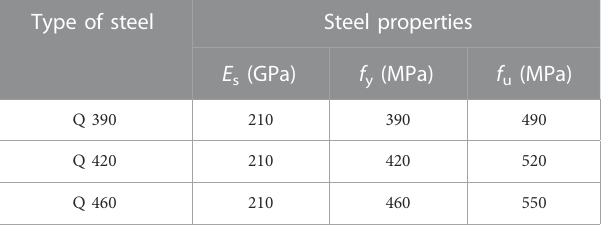
TABLE 4 Steel properties of the shear